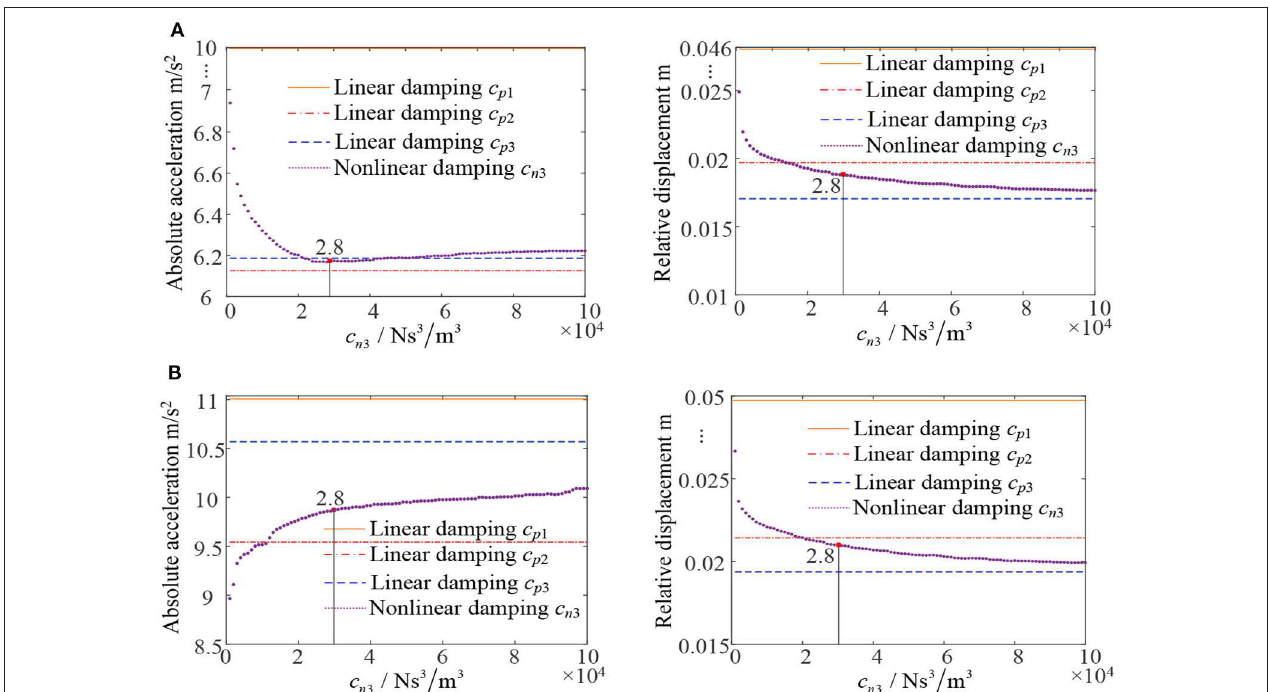
FIGURE 10 | Maximum output acceleration and inter-story drift under Type 1 ground motion. (A) Absolute acceleration and inter-story drift of the first floor. (B) Absolute acceleration and inter-story drift of the second floor.